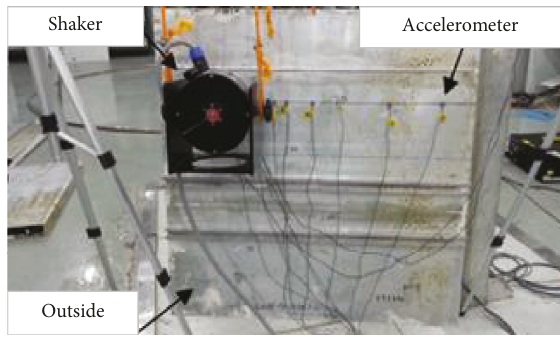
Figure 9: ESEA test process of excitation point A.